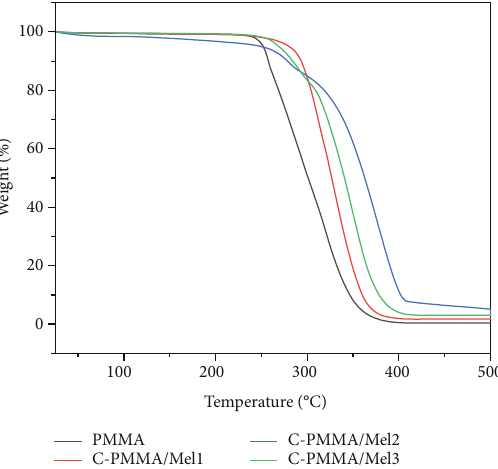
Figure 3: TGA micrograph of pure PMMA and C-PMMA/Mel(1 – 3).